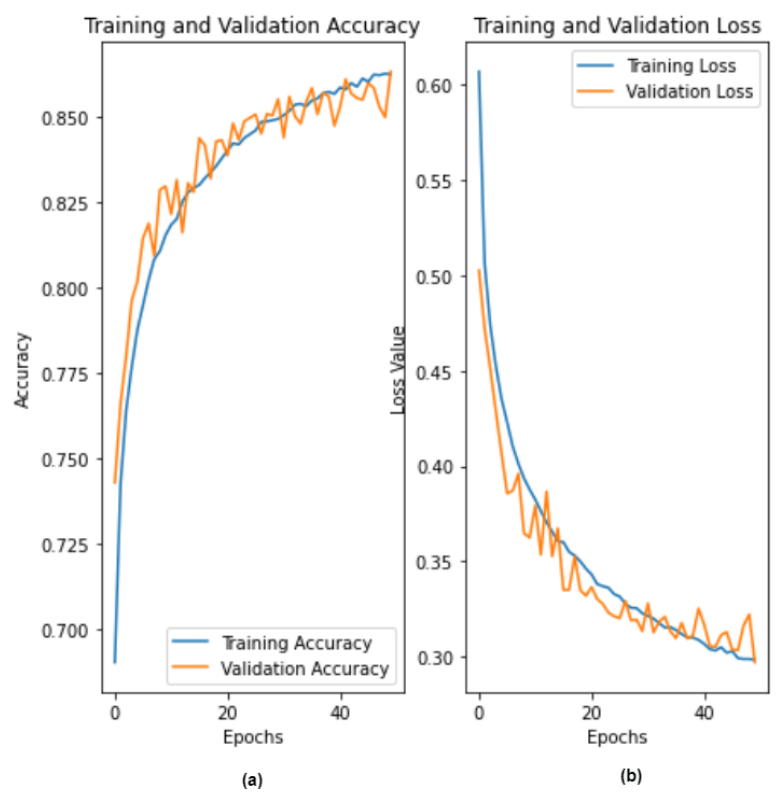
Figure 8. Performance graph of the proposed 2D-CNN model ( a ) accuracy (epochs vs. accuracy) and (b) loss (epochs vs. loss).